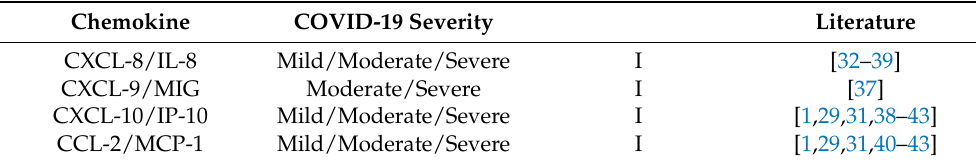
Table 1. Elevated chemokine serum levels in COVID-19 patients Abbreviations: I, increased; ND, no difference to healthy controls .